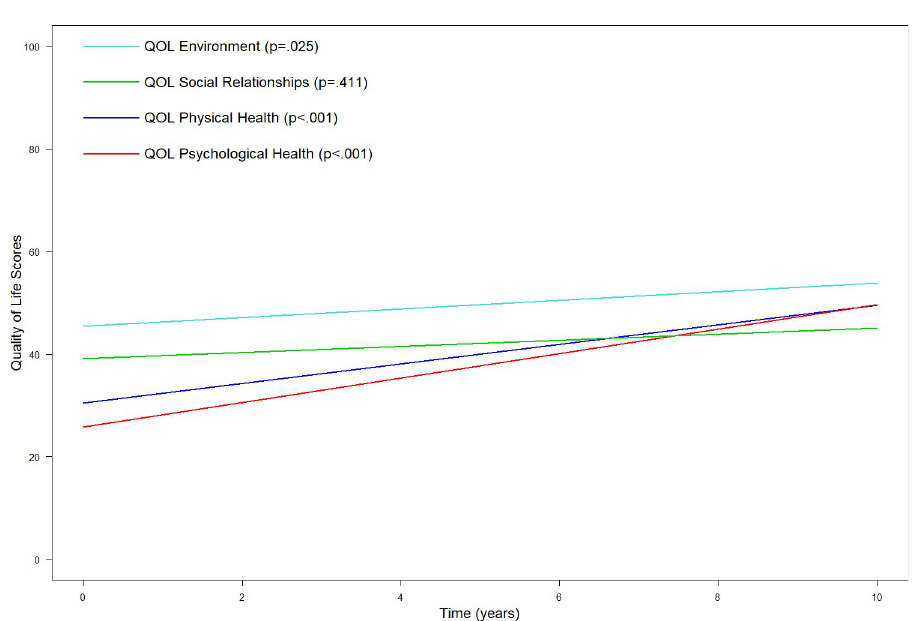
Fig 2. Improvement in quality of life over time. Improvements in Quality of Life were significant in the domains Physical Health and Psychological Health ( p < .001), and Environment ( p = .025). Quality of Life: WHOQOL-Bref [65]. The plot illustrates the trajectories over 10 years from study inclusion/treatment